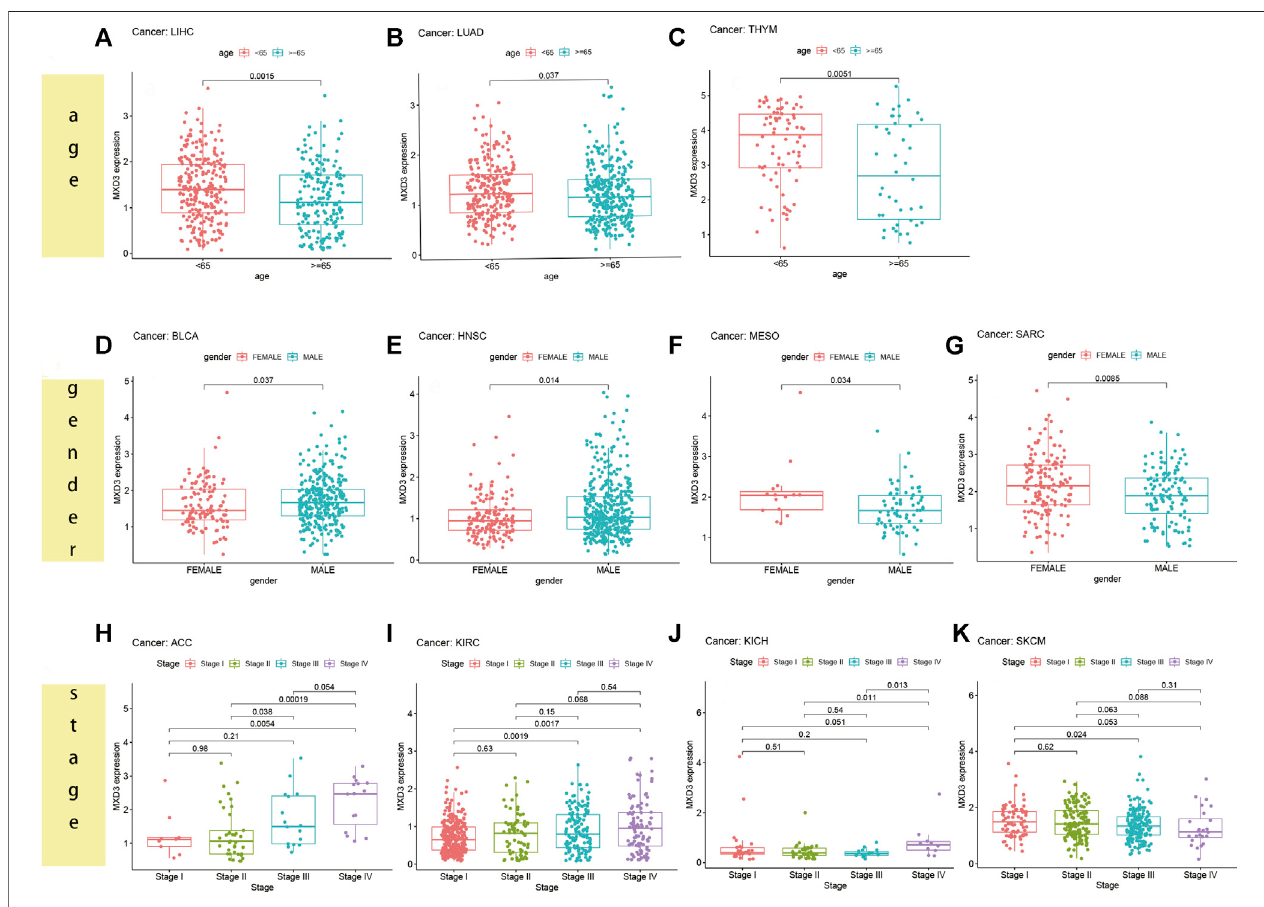
FIGURE 8 | MXD3 expression of different clinical phenotypes of age in LIHC (A) , LUAD (B) , and THYM (C) . MXD3 expression of different clinical phenotypes of gender in MESO (F) , SARC (G) , BLCA (D) , and HNSC (E) . MXD3 expression of different clinical phenotypes of stage in ACC (H) , KIRC (I) , KICH (J) , and SKCM (K) .